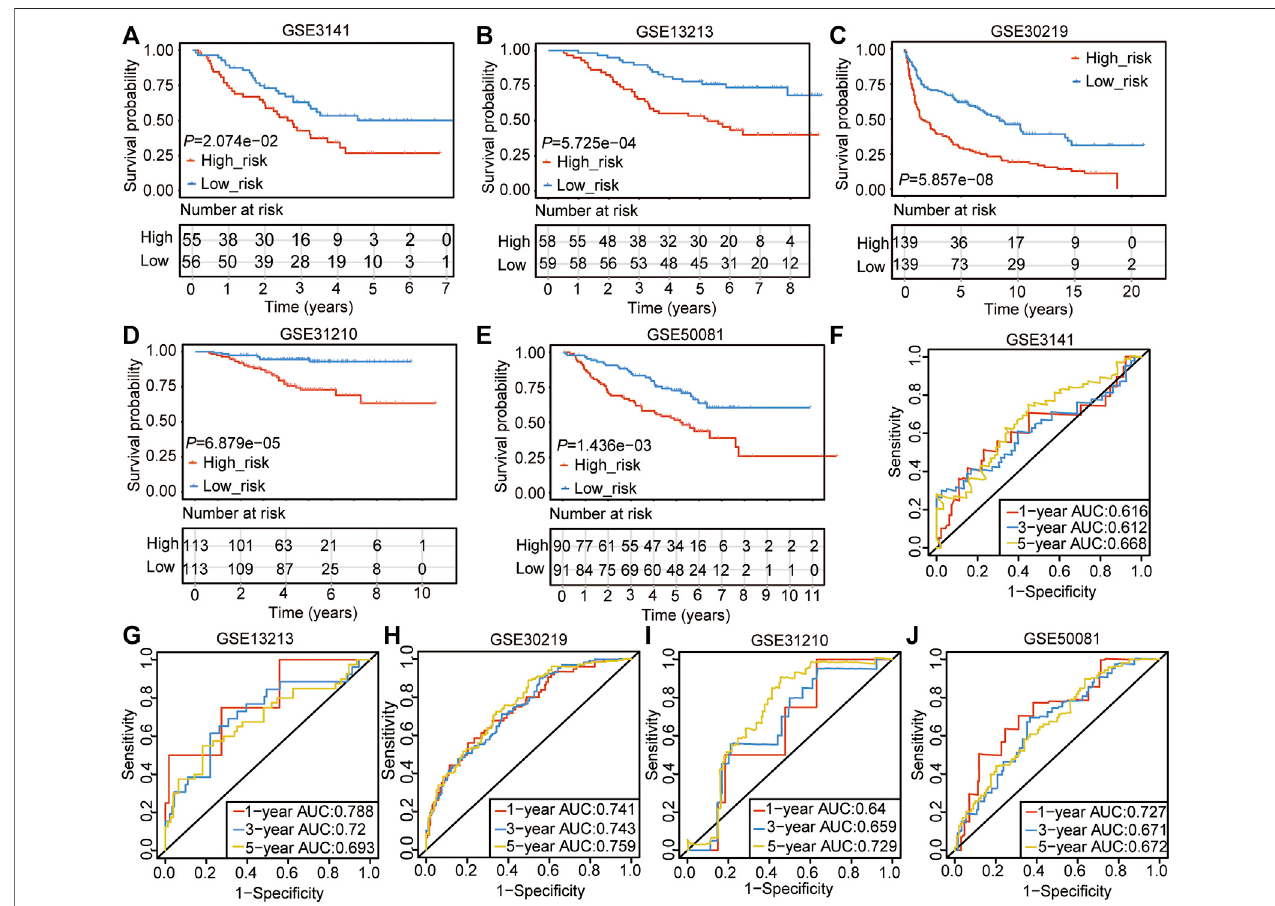
FIGURE 4 | Validation of the CSRs-related prognostic signature with GEO datasets. (A – E) The overall survival of the high- and the low-risk group in the fi ve validation sets. (F – J) ROC analyses of the cox model for 1-, 3-, and 5-years in the fi ve validation sets.